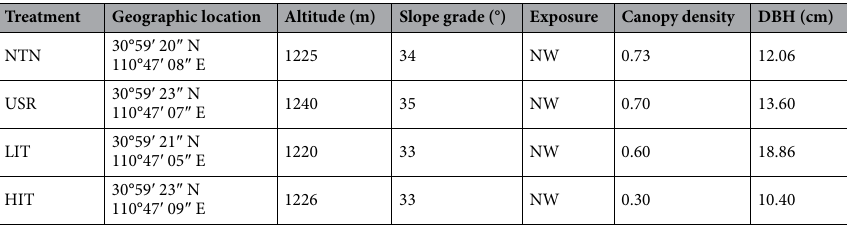
Table 1. Characteristics of the P. massoniana plantation with no thinning (NTN), understory removal (USR), light-intensity thinning (LIT) and heavy-intensity thinning (HIT) treatments in